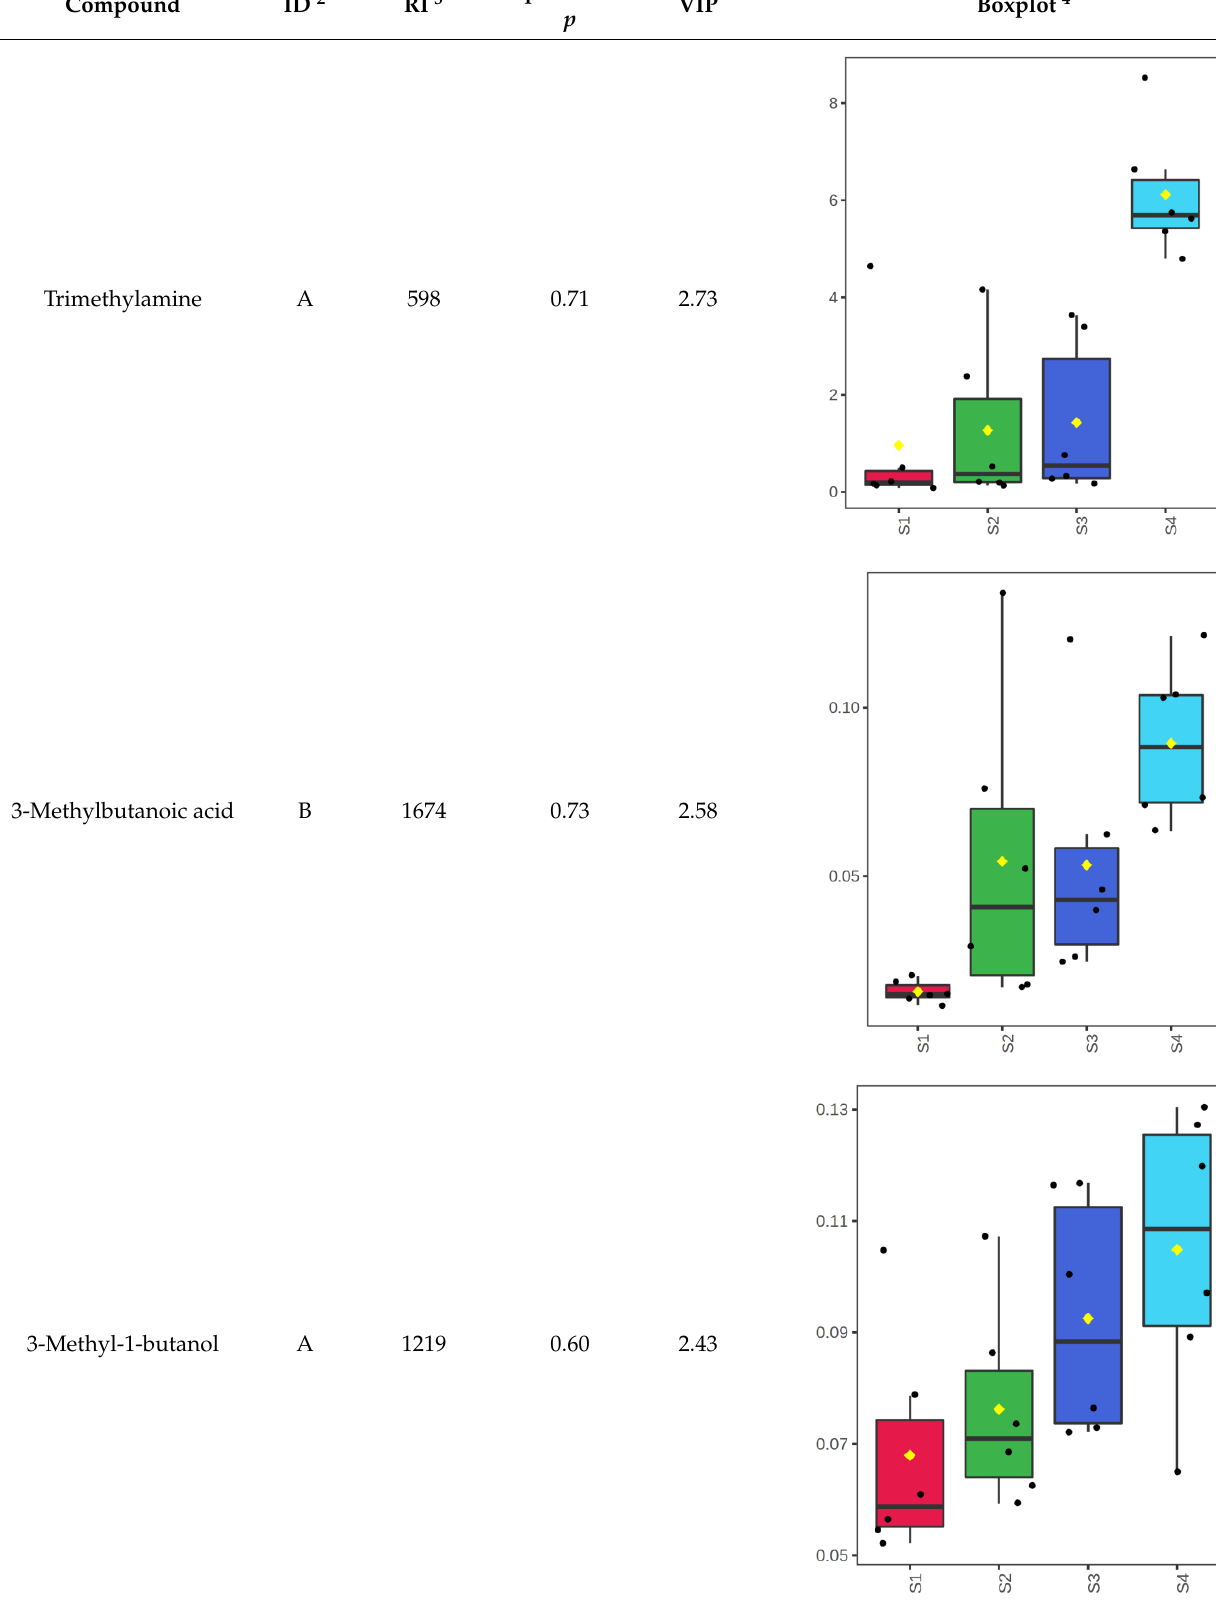
Table 2. Volatile compounds correlated significantly 1 with the storage period of filleted meagre at 4 °C.